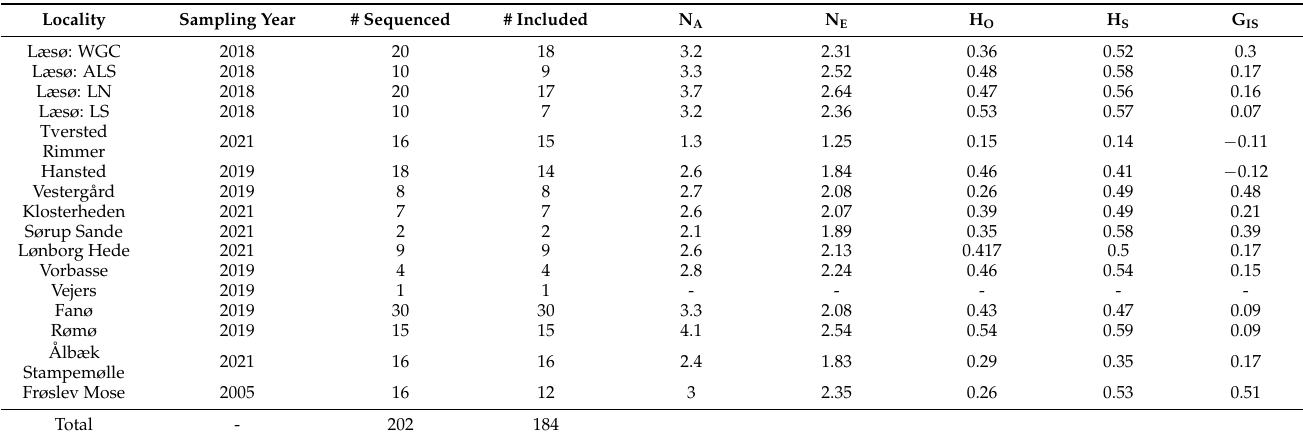
Table 1. Summary of samples, genetic diversity (N A = number of alleles, N E = effective number of alleles, H O = observed heterozygosity, H S = expected heterozygosity), and estimated inbreeding (G IS ) for the contemporary